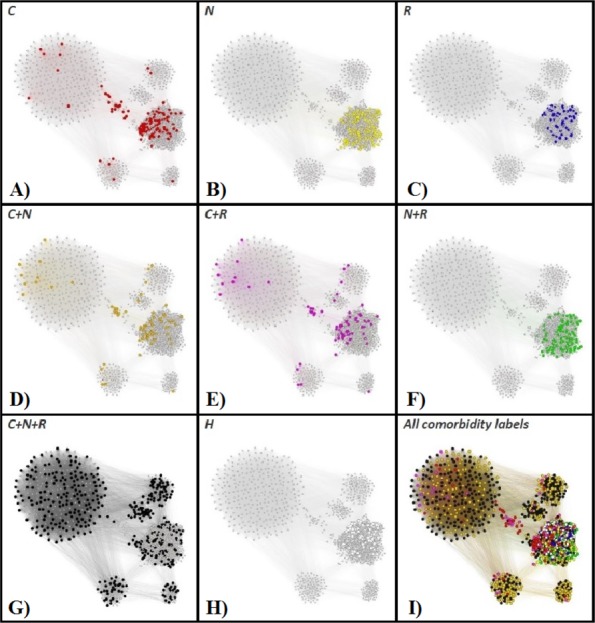
The Apnea Patients Network (APN), with highlighted individual comorbidities and associations of comorbidities.The red nodes correspond to patients that have only cardiovascular comorbidities (C in A), the yellow nodes to only nutrition-related (N in B), and blue nodes represent OSAS patients with only respiratory comorbidities (R in C). Patients with overlapping comorbidity types are represented within the APN as follows: orange nodes correspond to cardiovascular plus nutritional comorbidities (C + N in D), purple nodes to cardiovascular plus respiratory comorbidities (C + R in E), green nodes to nutritional plus respiratory comorbidities (N + R in F), and black nodes to the superposition of cardiovascular, nutritional and respiratory comorbidities (C + N + R, G). The OSAS patients without known comorbidities are highlighted in the APN as white nodes (H in H). We also provide the APN where all nodes are labeled according to their comorbidity or comorbidities overlapping in I.